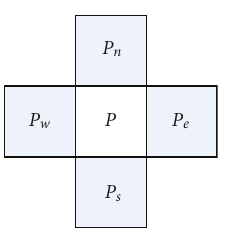
Figure 1: The structure of adjacent pixels in embedding process.